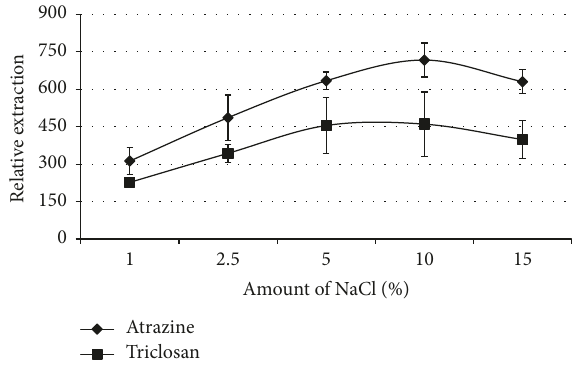
Figure 3: The effect of adding sodium chloride on the extraction. Conditions: volume, 1mL of 5 𝜇 g/mL triclosan and atrazine aqueous sample; 1: 4 (v/v) chlorobenzene : ethyl acetate mixture with the extraction time of 20 minutes and with toluene as the acceptor solvent.